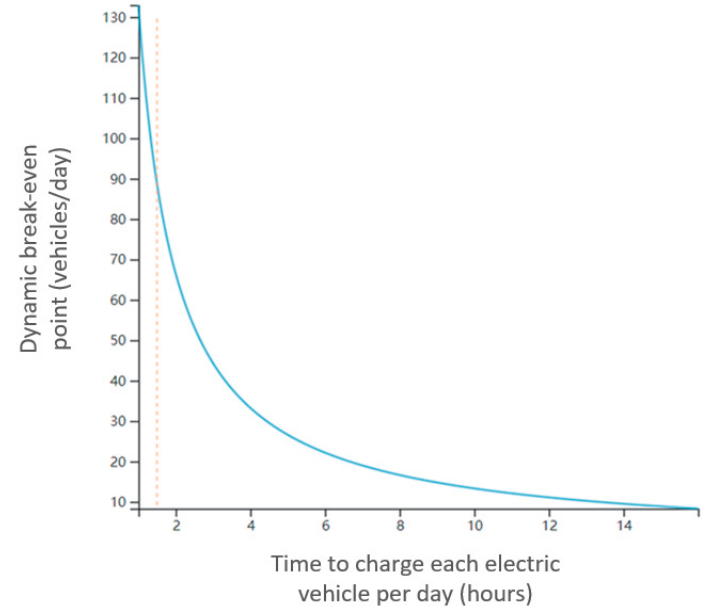
Figure 8. Sensitivity analysis of the daily charging time of electric vehicles.